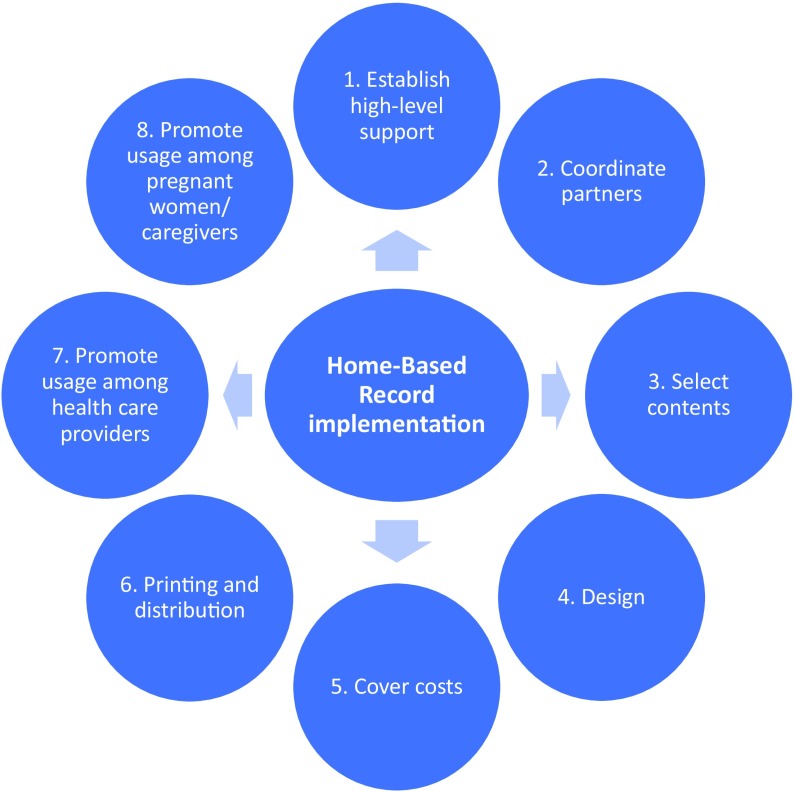
Eight Components of a Successful Home-Based Record Program Implementation Process